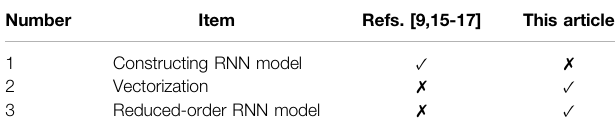
TABLE 1 | Main novelties and differences of this article from the relevant